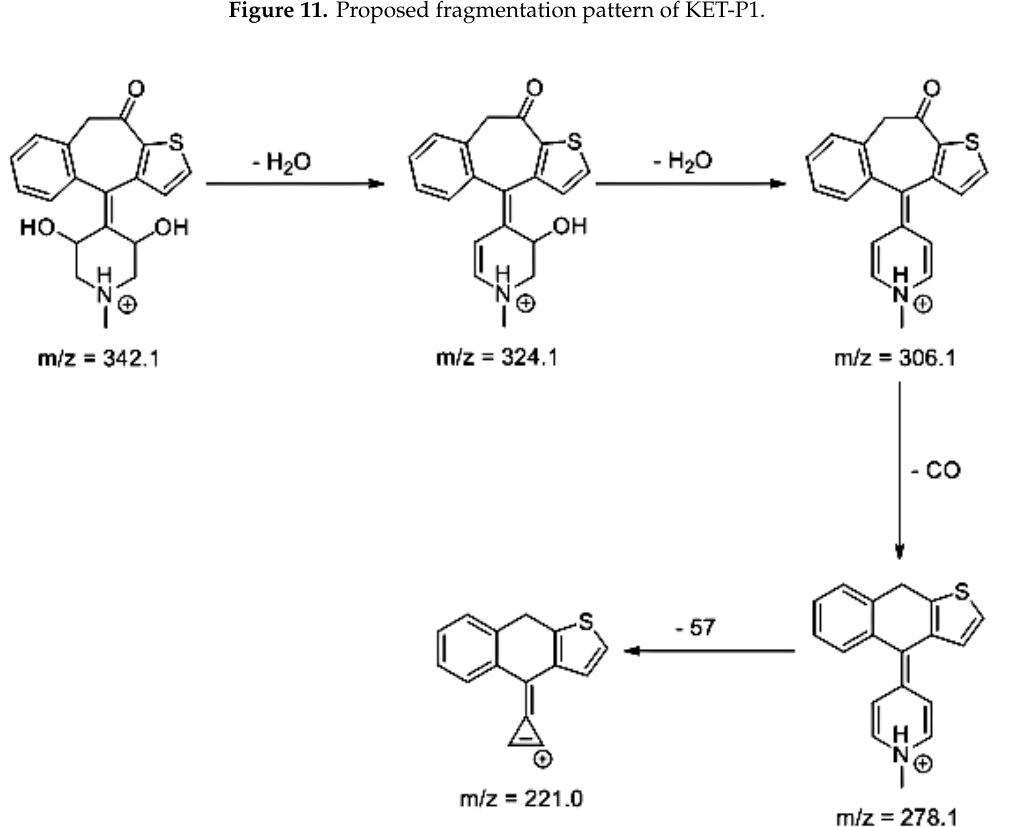
Figure 12. Proposed fragmentation pattern of KET-P2.